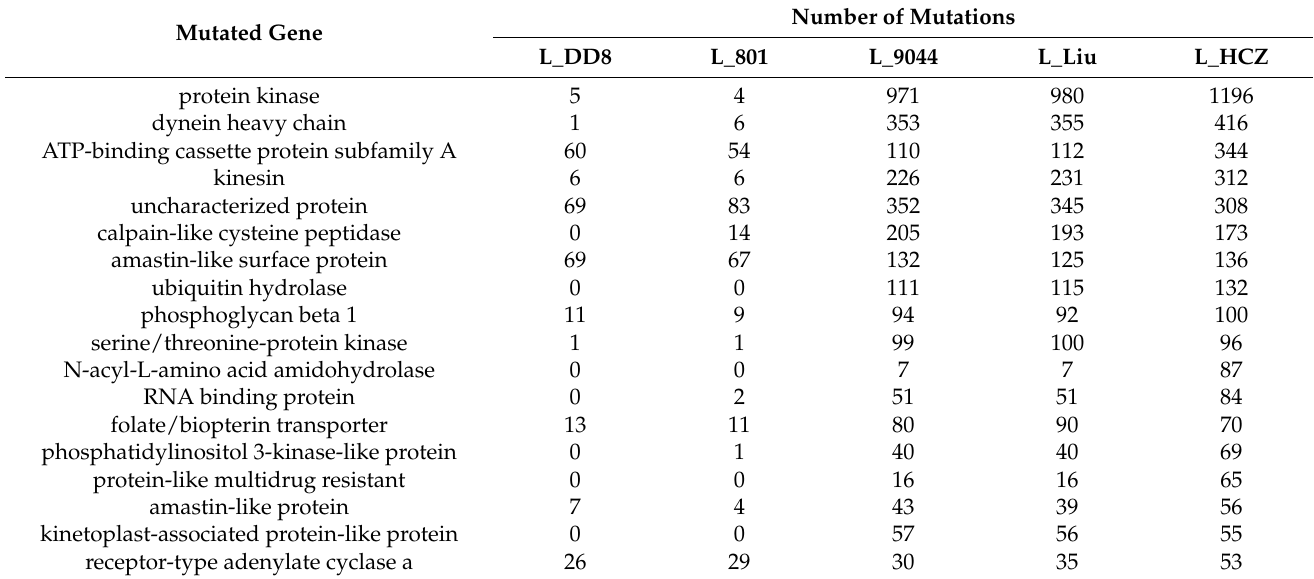
Table 5. Mutation analysis of 18 genes in five Leishmania